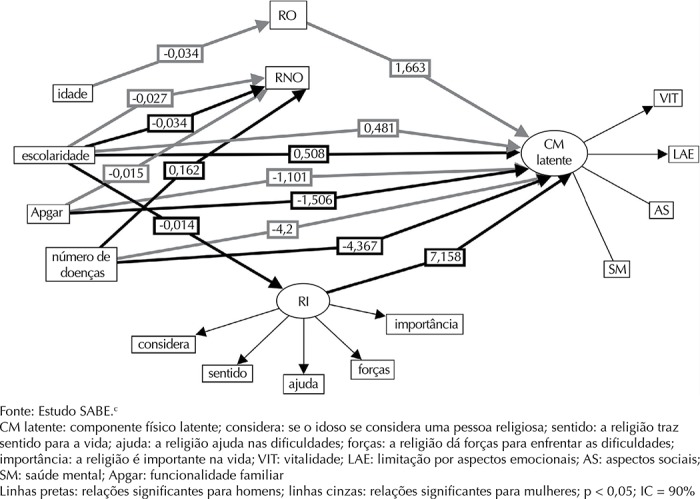
Representação do modelo estrutural e de mensuração usando a modelagem de equações estruturais com as influências das variáveis sobre o componente mental para homens e mulheres idosos. São Paulo, SP, Brasil, 2006.